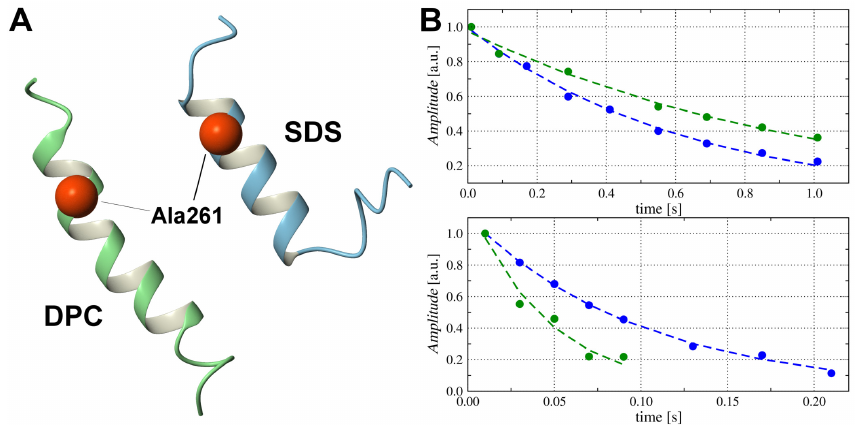
Figure 5. ( A ) The 3D structure of TM4 fragment in SDS- d 25 and DPC- d 38 surfactants is presented. The position of 15 N nuclei in 15 N-labeled Ala261 are depicted as balls. ( B ) Experimental R 1 (up) and R 2 (down) relaxation decay recorded at 18.1 T for 15 N-labeled Ala261 inside SDS- d 25 (blue) and DPC- d 38 (green)